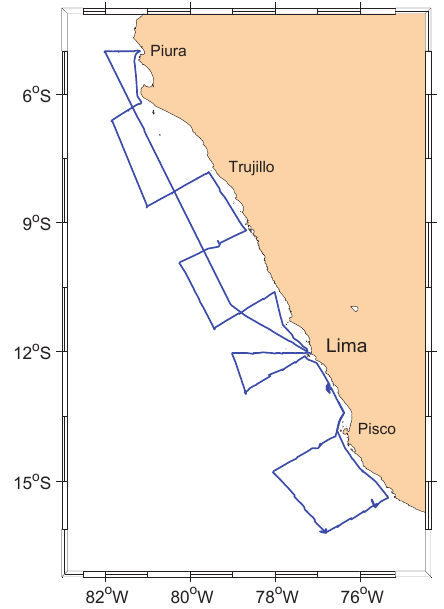
Figure 4. Track of cruise Meteor M91 . From Lima, the ship first sailed north until about Piura and then continued south along tran- sects from the open ocean to the coastal upwelling or vice versa until 18 ◦ S, from where it returned to